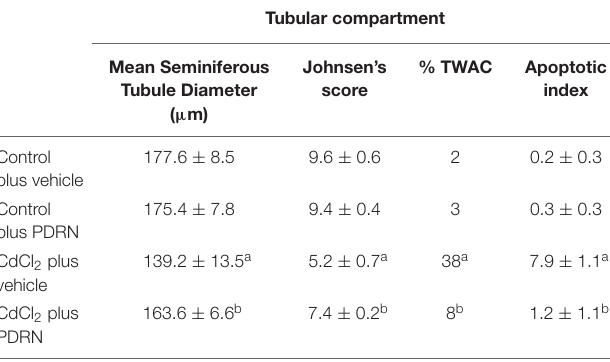
TABLE 1 | Effects on testis tubular compartment for the two types of control animals (Control plus vehicle; Control plus PDRN) and the two types of treated ones (CdCl 2 plus vehicle; CdCl 2 plus PDRN).